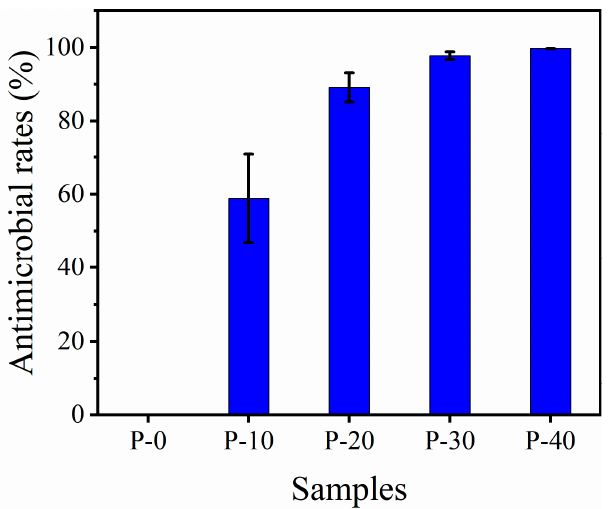
Figure 7. Antibacterial rate of P–0, P–10, P–20, P–30, and P–40 monofilaments against Escherichia coli after sample culture for 24 h.